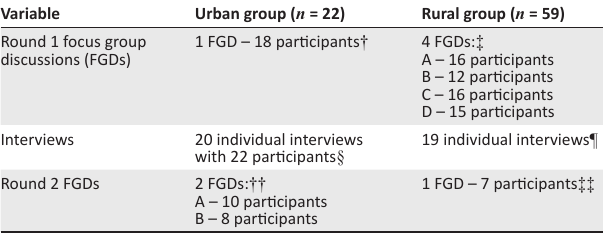
TABLE 2: Data collection